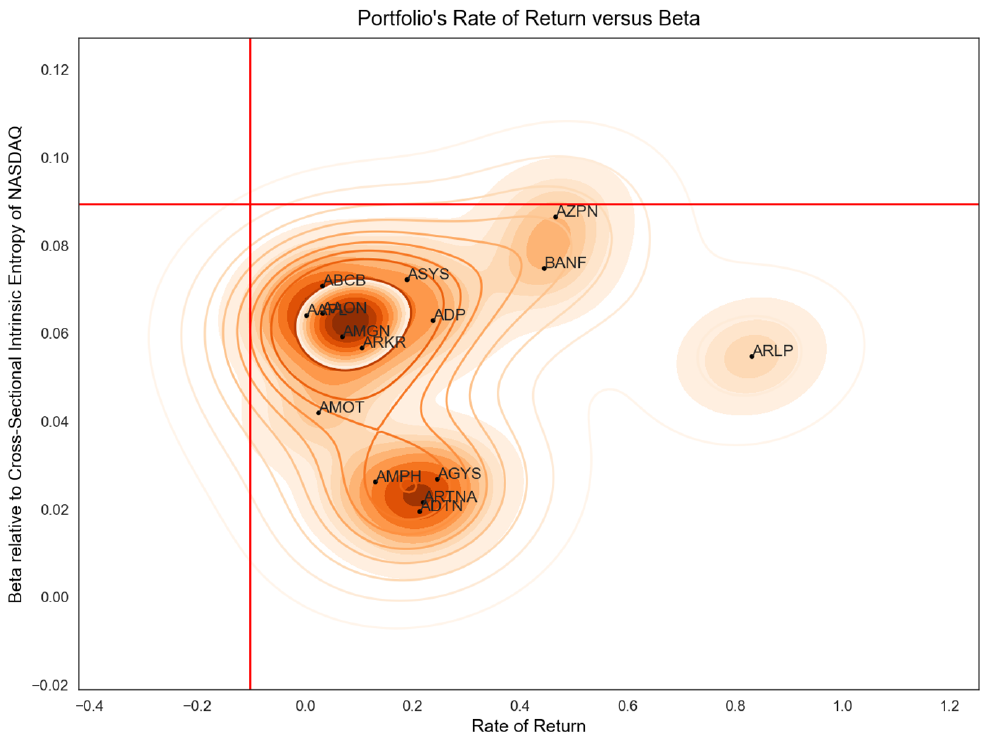
Figure 4. A set of 15 NASDAQ symbols that outperformed the NASDAQ Composite index in terms of rate of return without being exposed to higher risk (125-day trading interval, from 1 March 2022 to 26 August 2022) .